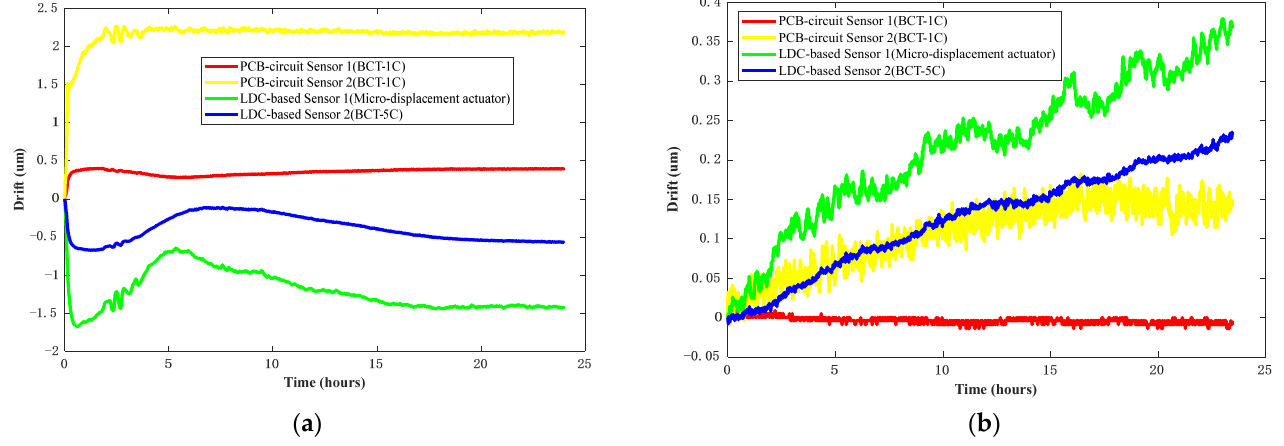
Figure 9. Test results for long-term stability or time drift under controlled temperatures: ( a ) Time drift within 24 h after installation; ( b ) Time drift after 24 h of stability.